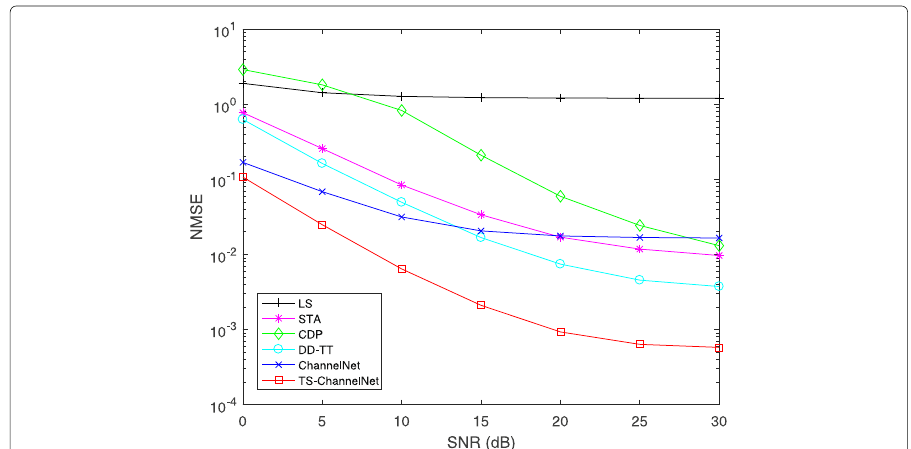
Fig. 3 NMSE with 4QAM modulation, maximum Doppler = 300 Hz, and 60 OFDM symbols (RTV Expressway)